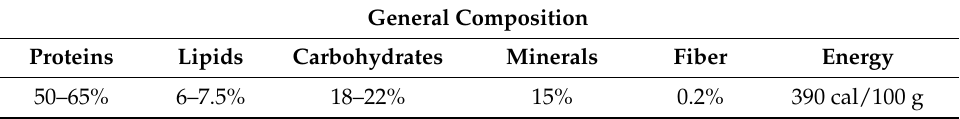
Table 2. Composition of spirulina from ASN LEADER S.L., provided by the